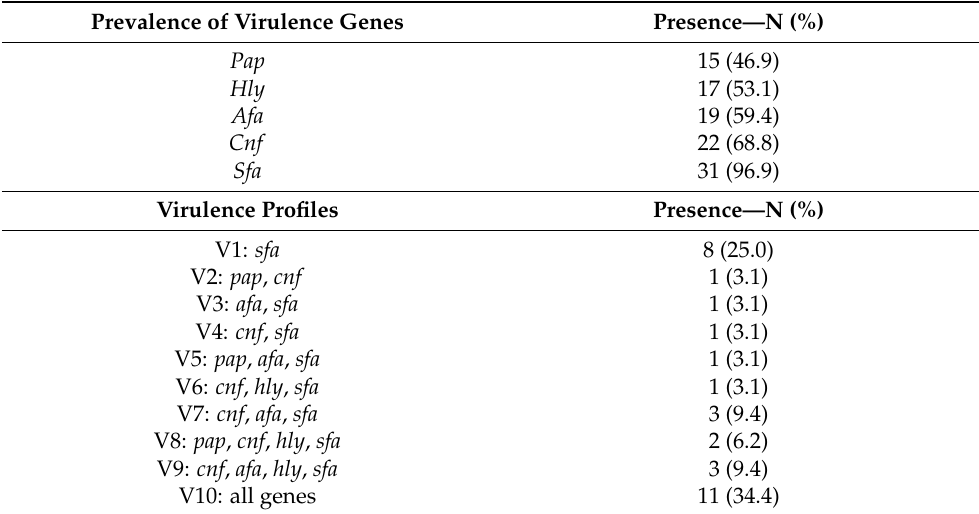
Table 3. Prevalence of virulence genes and profile of virulence of E. coli from female dogs with